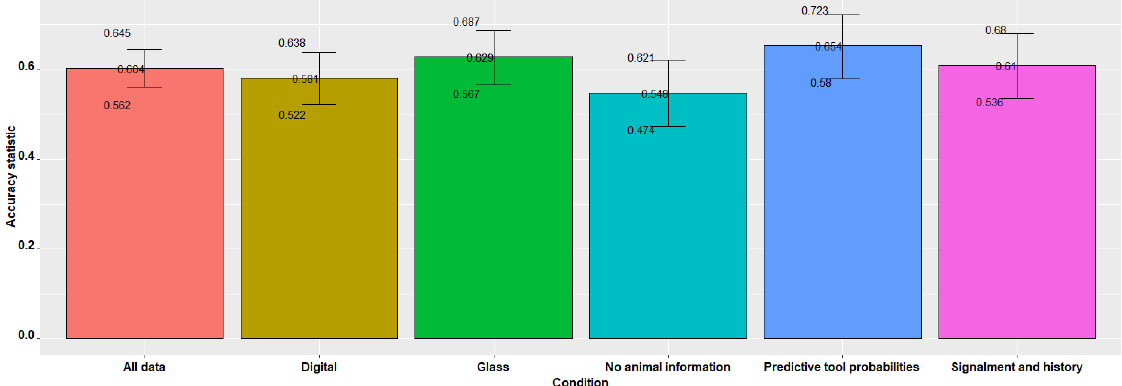
Figure 4. Concurrence of the four pathologists’ diagnoses of canine and feline bladder tissues compared with the reference diagnosis.